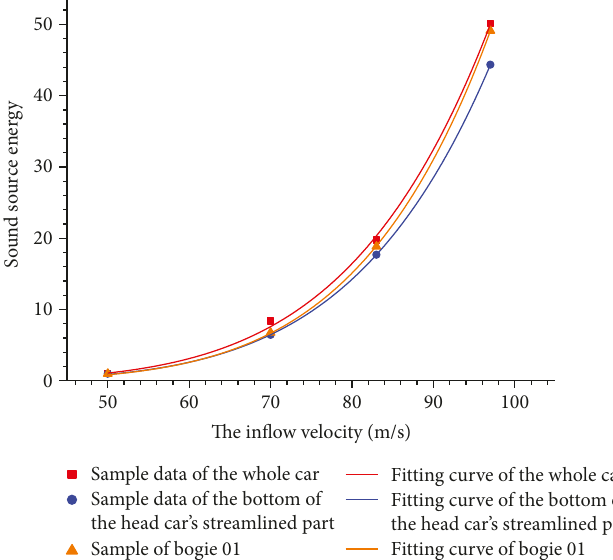
Figure 18: Functional relationship between the sound source energy and the in fl ow velocity.